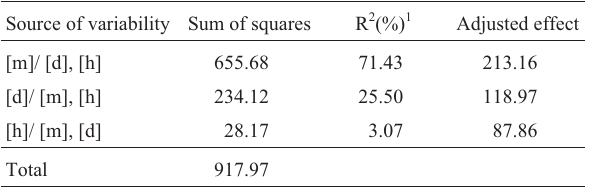
Table 2 - Non-orthogonal decomposition of the model sum of parameter squares adjusted for area under the disease progress curve (AUDPC)